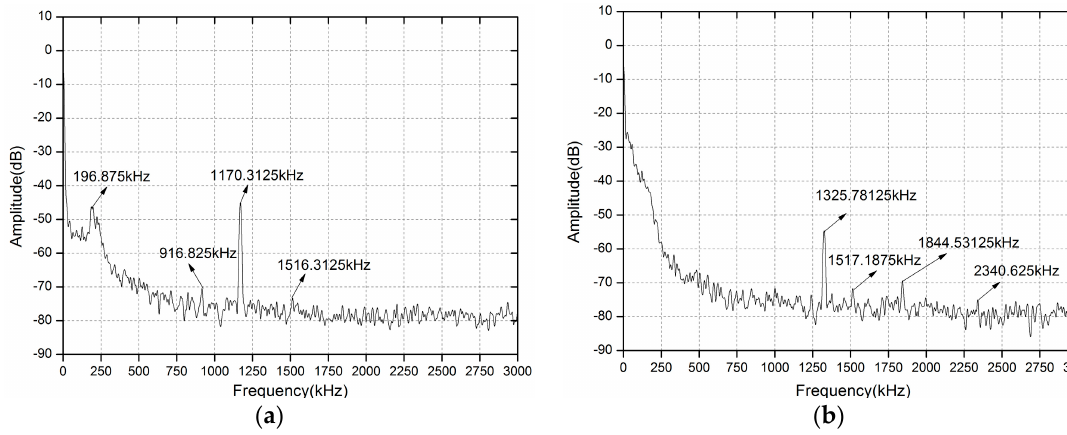
Figure 6. Typical Doppler signal displayed on the spectrum analyzer of different velocities with θ = 60°. ( a ) v = 1814.88 mm/s; ( b ) v = 2053.68 mm/s.